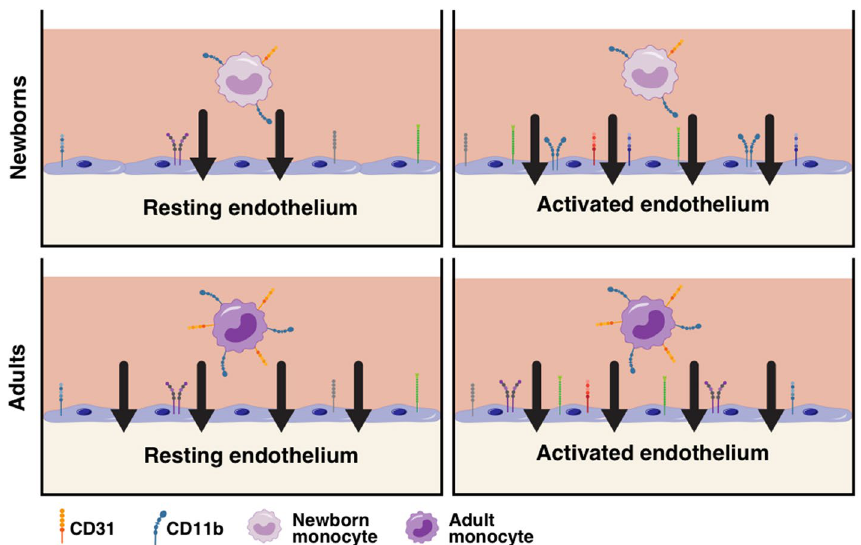
Figure 7. Neonatal monocytes demonstrate impaired homeostatic extravasation into a microphysiological human vascular model. To study the ability of monocytes to undergo autonomous transendothelial extravasation through a confluent human endothelium under biologically accurate circumstances we engineered a three-dimensional human vascular-interstitial model. Our results suggest that neonatal monocytes are intrinsically impaired to migrate through resting endothelia but maintain sufficient capacity to extravasate activated endothelia as efficiently as their adult counterparts. Newborn monocytes demonstrated significantly lower surface expression of CD31 and CD11b, and mechanistic experiments using blocking antibodies confirmed a functional role for CD31 and CD54 in neonatal homeostatic extravasation. To the extent this microphysiological model reflects the behaviour of monocytes in vivo, this phenomenon could contribute to the divergent immune responsiveness to vaccines and the susceptibility to infections observed during early